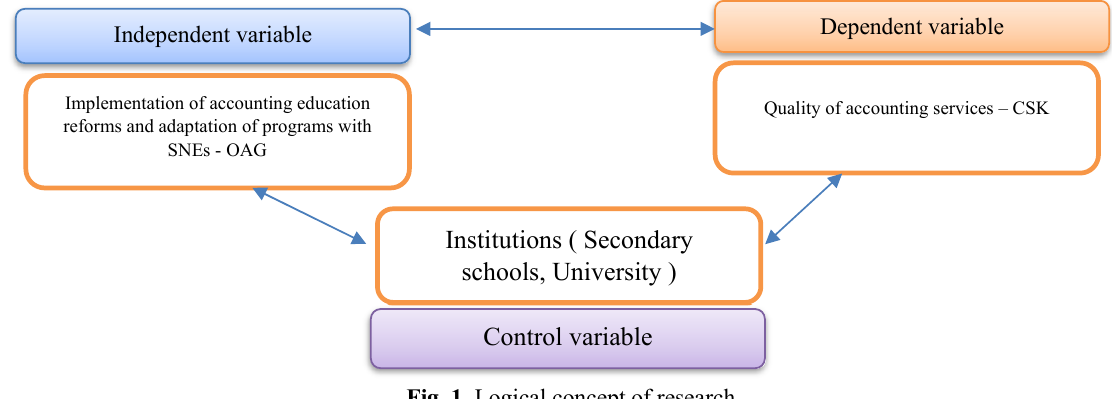
Fig. 1. Logical concept of